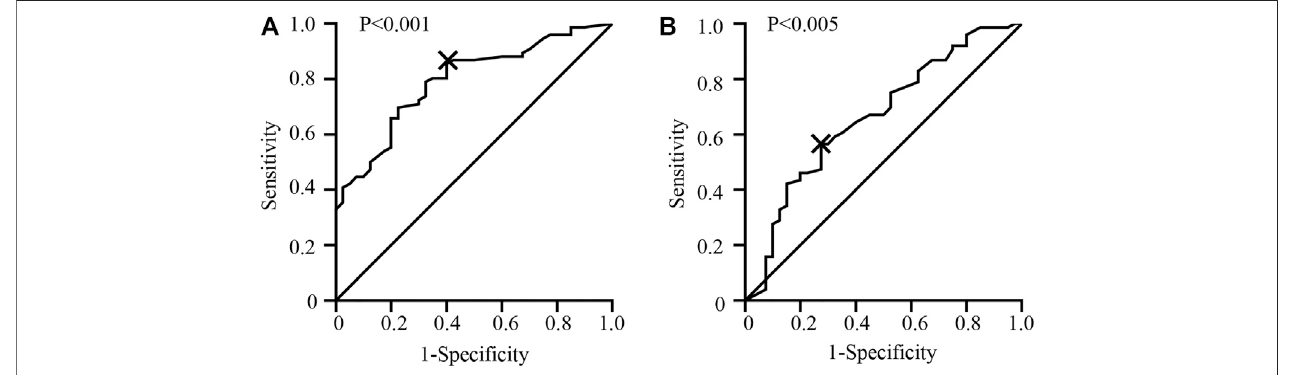
FIGURE 3 | (A) ROC curve analysis identifying the appropriate cut-off value of CTC-TRPC5 score with 8.6 (AUC (cid:1) 0.793; 95% CI (cid:1) 0.712 – 0.875). (B) ROC curve analysis identifying the appropriate cut-off value of IHC-TRPC5 score with 8 (AUC (cid:1) 0.664; 95% CI (cid:1) 0.5581 – 0.7695).